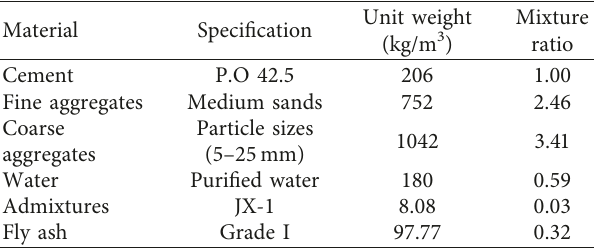
Table 2: Mix proportions of the concrete. Material